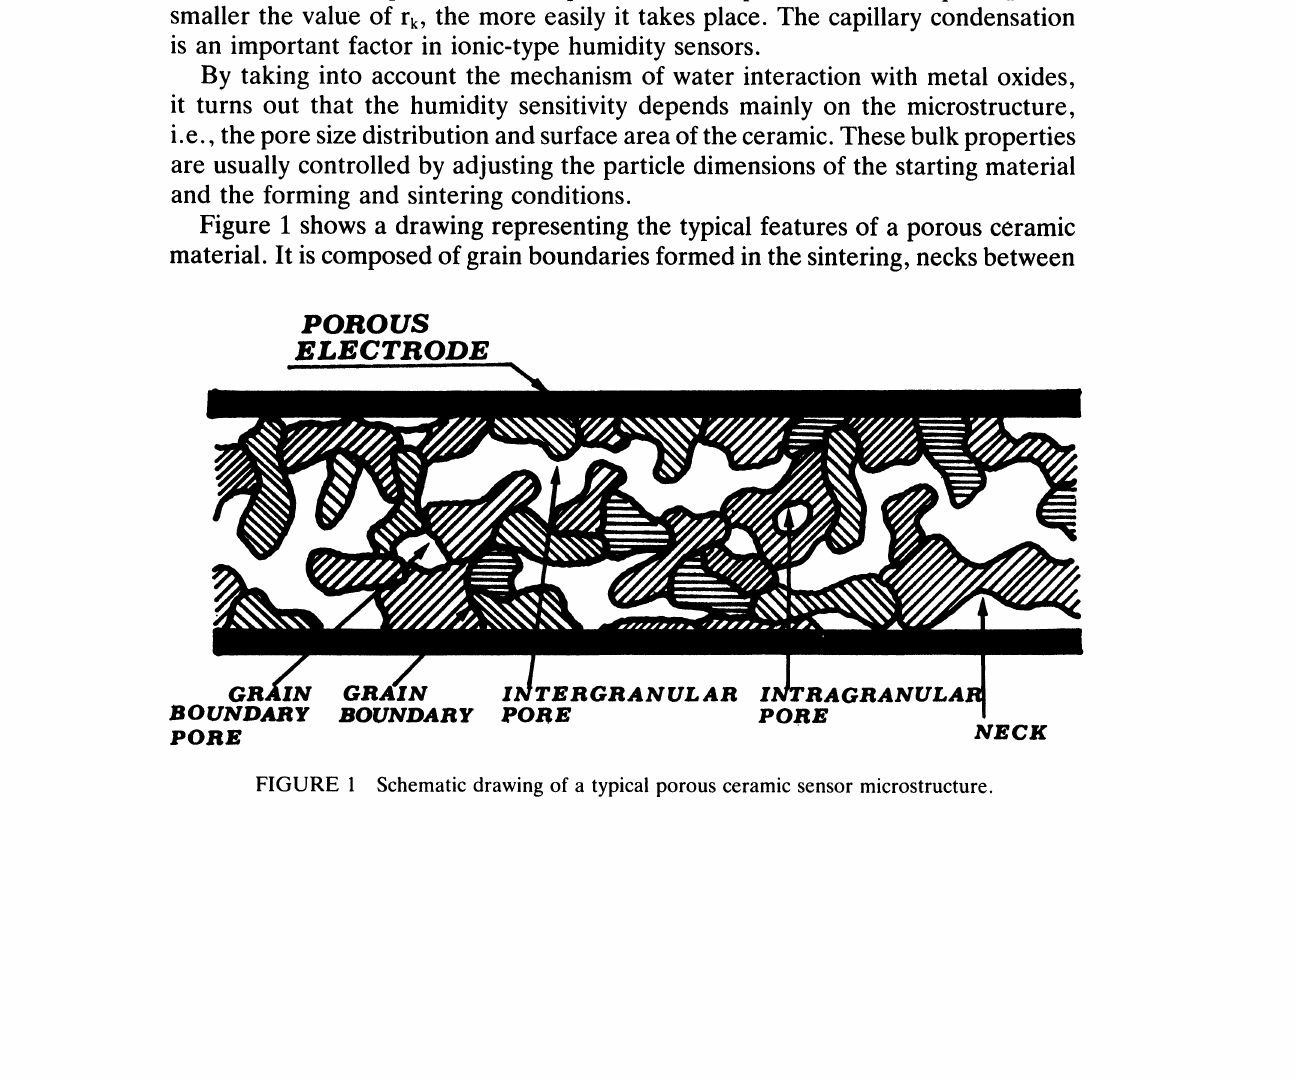
FIGURE Schematic drawing of a typical porous ceramic sensor